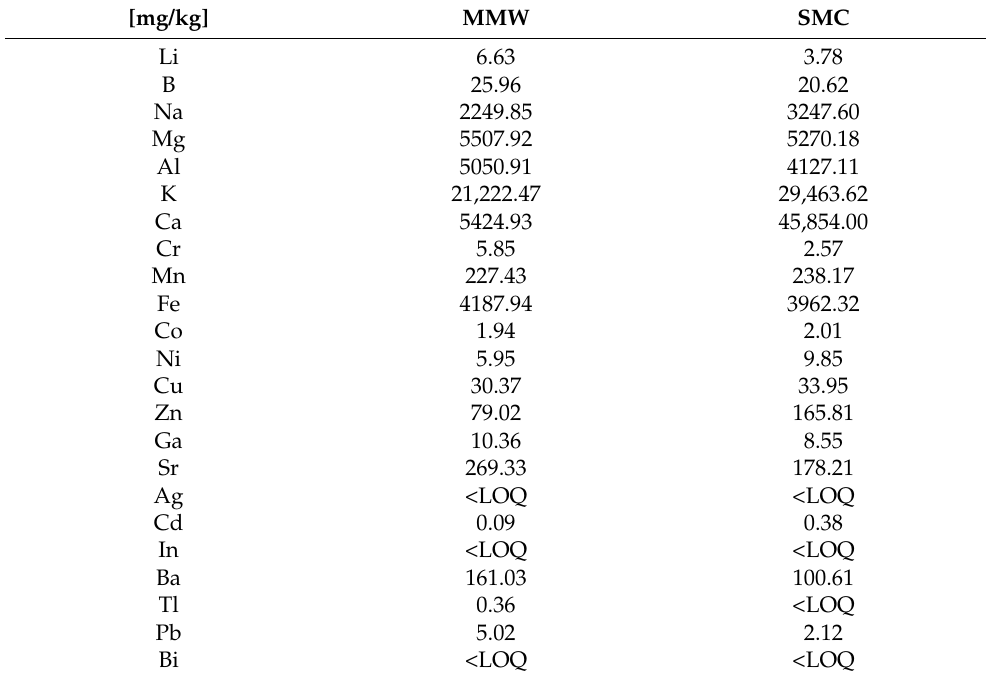
Table 4. Metal content of SCM and